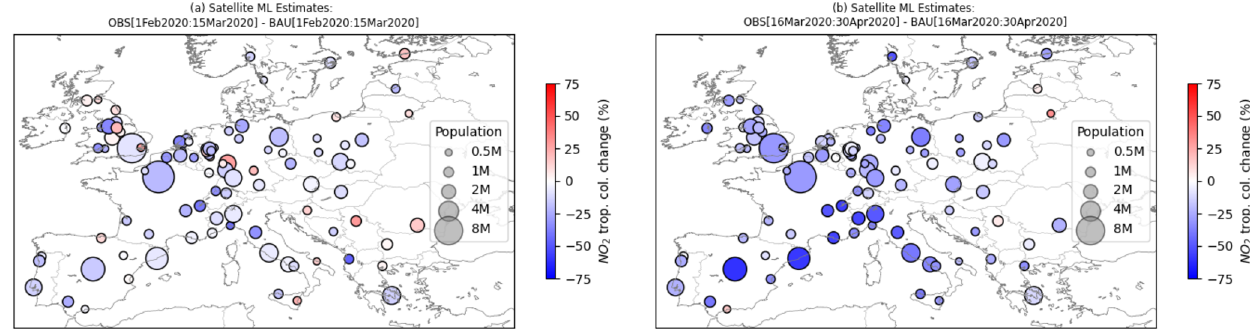
Figure 6. TROPOMI-based estimation of tropospheric NO 2 column change (%; relative to the BAU predictions) for urban areas with at least 0.5 million inhabitants, computed using the ML-based weather-normalization method for the pre-lockdown and lockdown periods ( a and b , respectively). The diameter of the circles is proportional to the population count in each urban area.